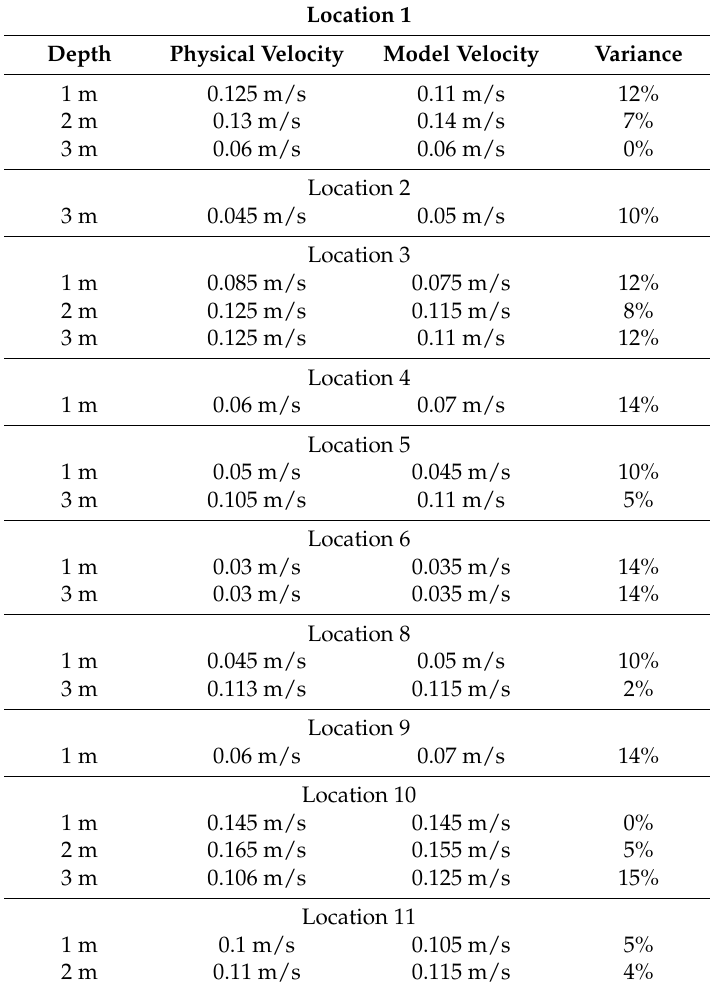
Table 2. Velocity results and comparison between CFD model and physical